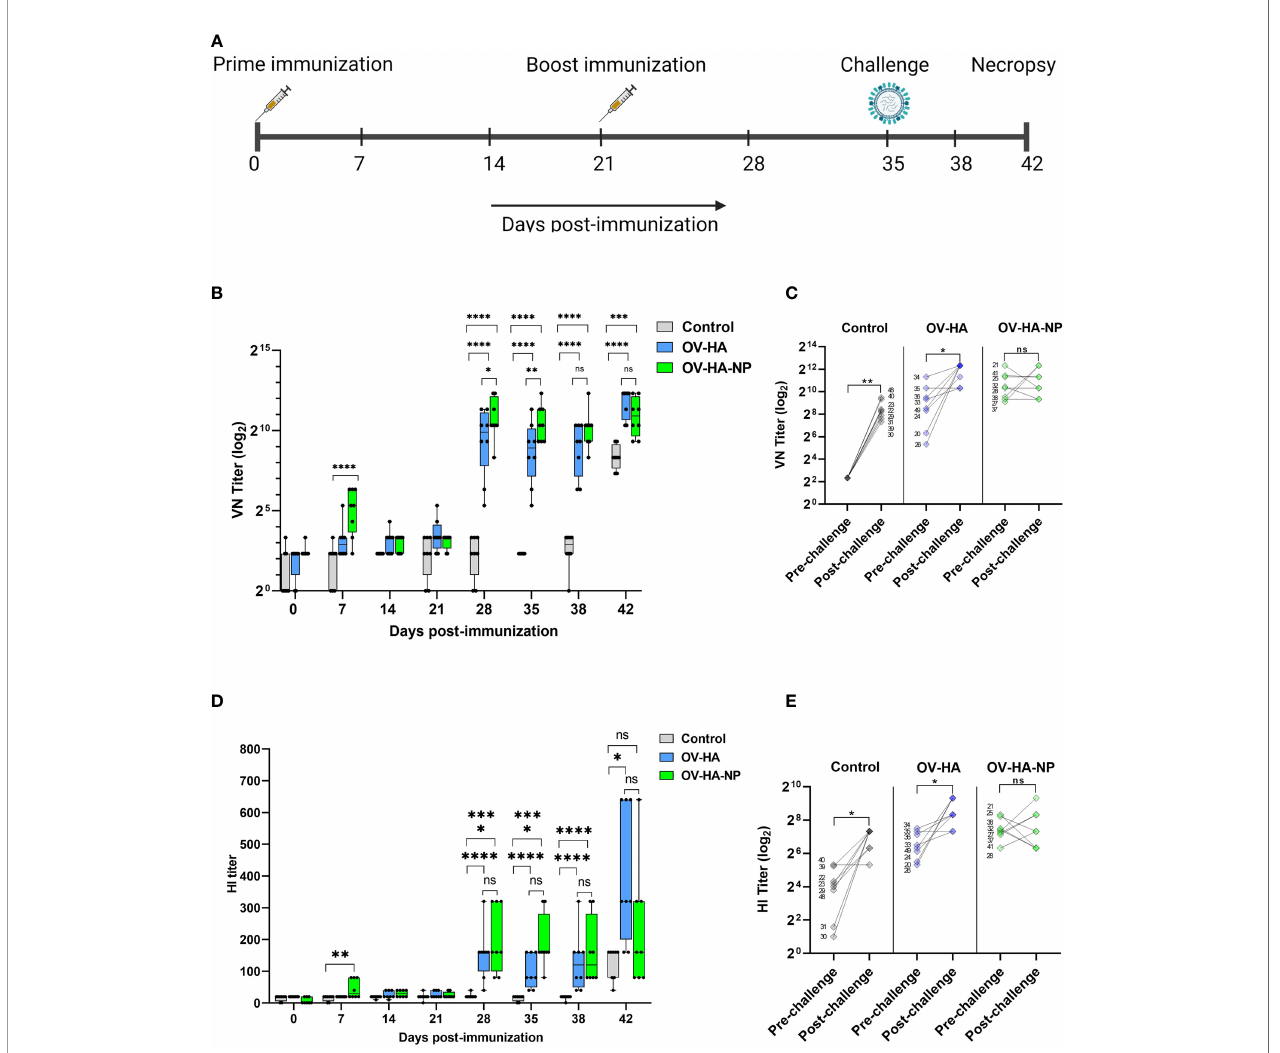
FIGURE 3 | Immunization-challenge experiment design and humoral response to immunization. (A) A timeline of immunization-challenge experiment. (B) IAV-S speci fi c neutralizing antibody response elicited by immunization with OV-HA and OV-HA-NP. (C) VN titer of individual animal measured on 0 dpc (pre-challenge) and 7 dpc (post-challenge). (D) IAV-S speci fi c humoral immune response induced by OV-HA and OV-HA-NP assessed by hemagglutination inhibition (HI) assay. Red arrow heads represent the day of challenge. The error bars represent SEM. VN titer shown in logarithmic scale for effective visualization. HI titer shown in liner scale. P-values: *P < 0.05, **P < 0.01, ***P < 0.001, ****P < 0.0001. (E) HI titer of individual animal measured on 0 dpc (pre-challenge) and 7 dpc (post-challenge). Wilcoxson rank sum test was used for comparing means (pre-challenge vs. post-challenge) within the groups. *P < 0.05; **P < 0.01; ns, non-signi fi